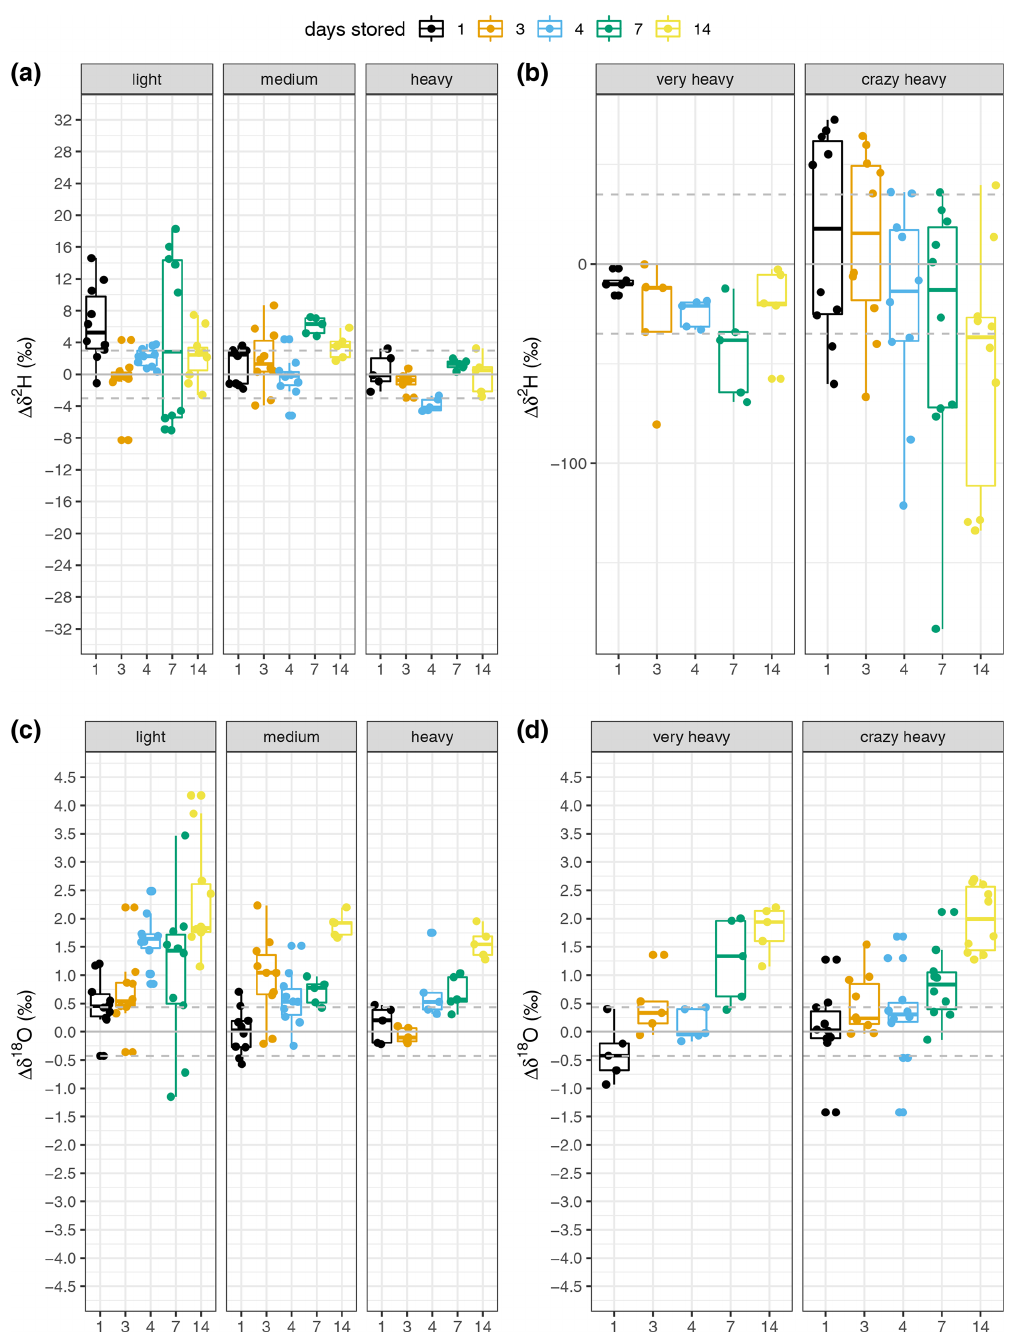
Figure 4. (a, b) δ 2 H and (c, d) δ 18 O change from the “0d” samples over storage times. Each measured source is represented by a facet and storage time is indicated by colour (see legend). Natural abundance sources are depicted in panels (a) and (c) , whereas the artificially enriched sources are represented in panels (b) and (d) . Data are represented by boxplots with the box showing the median as a line, the data between the 25th and 75th percentile as the box, the whiskers representing the minimum and maximum of the data. The dots indicate each data point measured and the horizontal lines represent the mean (solid) and standard deviation (dashed) of the “0d” samples. Note the scale change in panel (b)